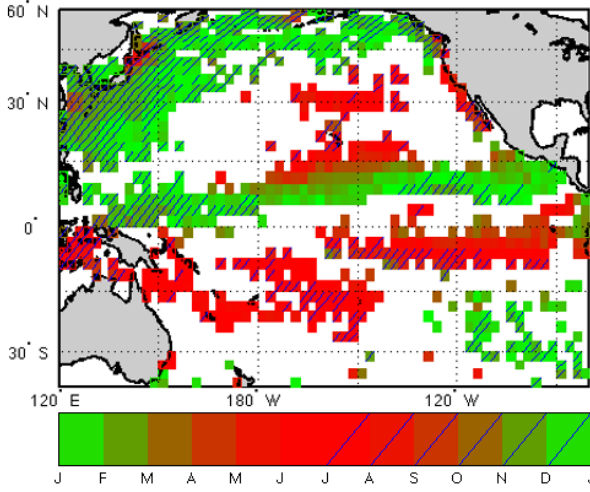
Fig. 9. Phase of the seasonal cycle of ∂S/∂t from the combined dataset. This figure presents the same information as Fig. 4 (with- out the TAO/TRITON data), shifted backward in time by 3 months. Color scale is shown at the bottom.